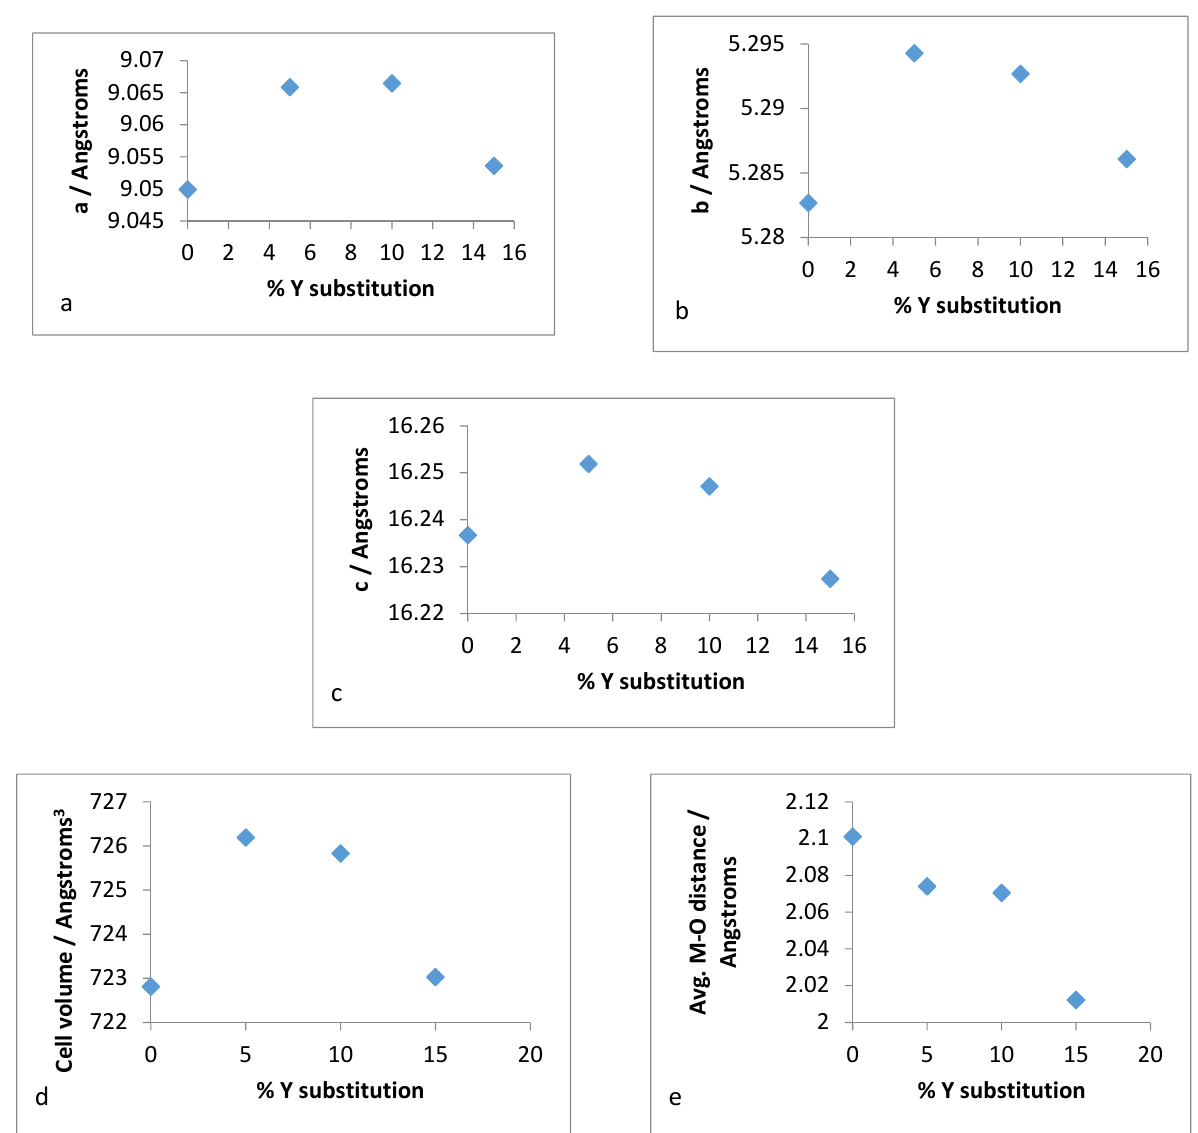
Figure 16. Unit cell parameters for: ( a ) a -axis, ( b ) b -axis, ( c ) c -axis, ( d ) volume and ( e ) mean M–O distance versus % Y substitution for conventional Y–ZrP.